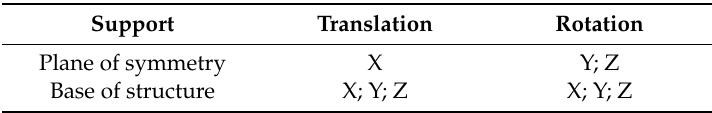
Table 3. Physical and material characteristics.